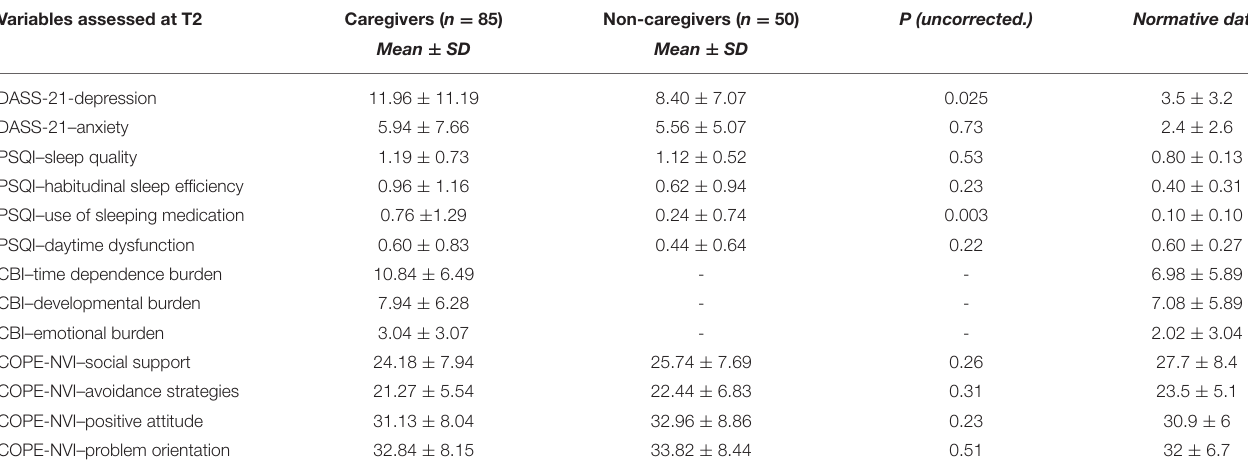
TABLE 1 | Descriptive measures (mean ± SD) of each questionnaires’ component with caregivers and non-caregivers’ comparisons. Descriptive measures (mean ± SD) for each component were shown by normative data (22, 23, 26). Variables assessed at T2 Caregivers ( n = 85) Non-caregivers ( n = 50) P